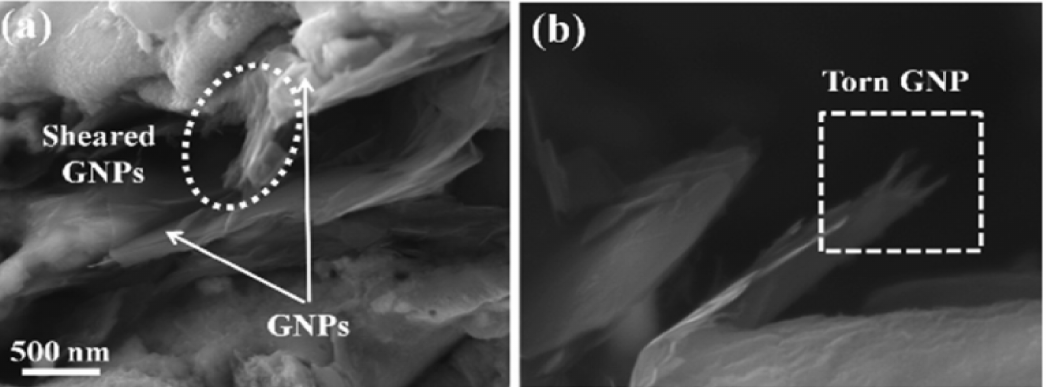
Figure 4. ( a , b ) FE-SEM image of high magnification revealing GNP after in situ tensile experimentation